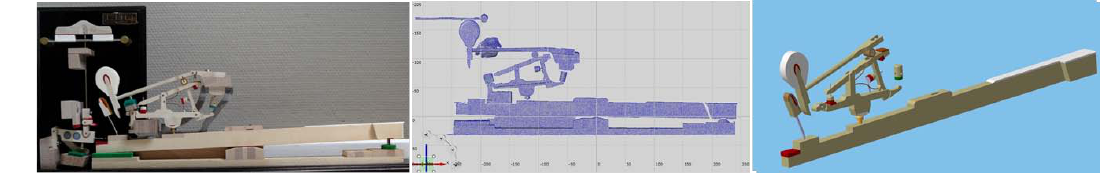
Figure 22. Real action mechanism (Left) – Scan of the action (Center) – Multibody model (Right).